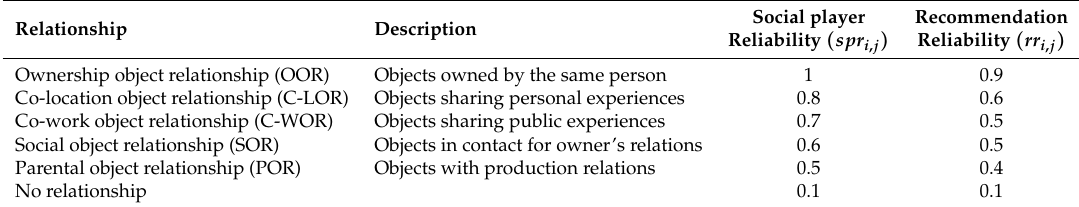
Table 1. Player and recommendation reliability values associated to the social relationship between